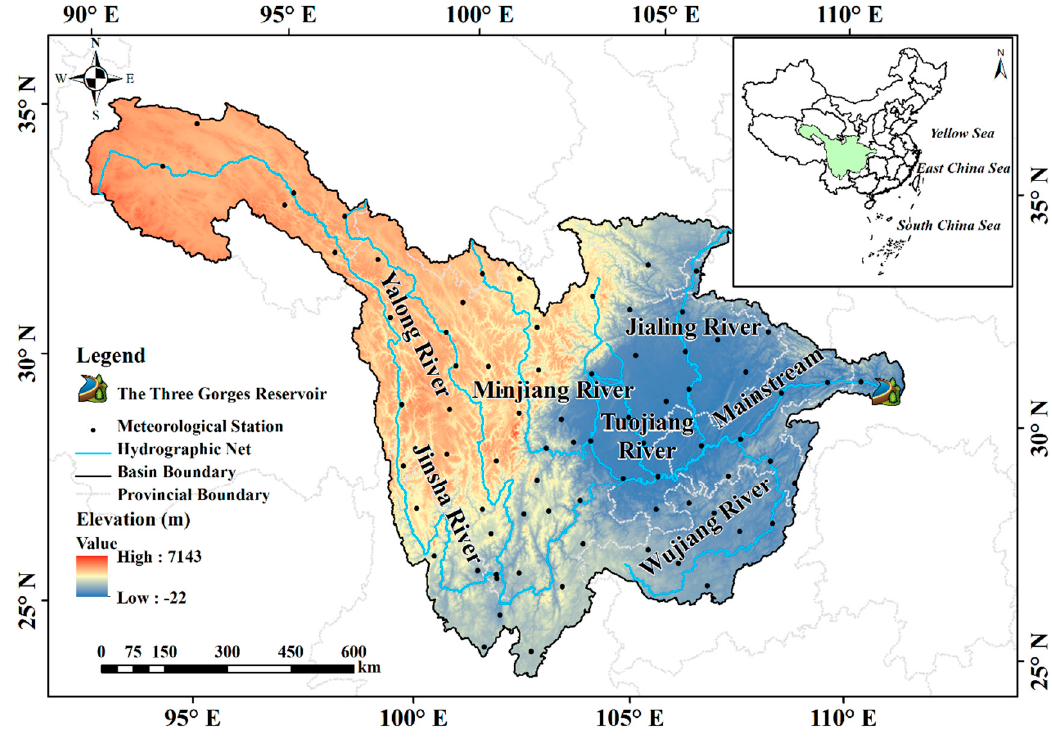
Figure 1. Map of the study area.